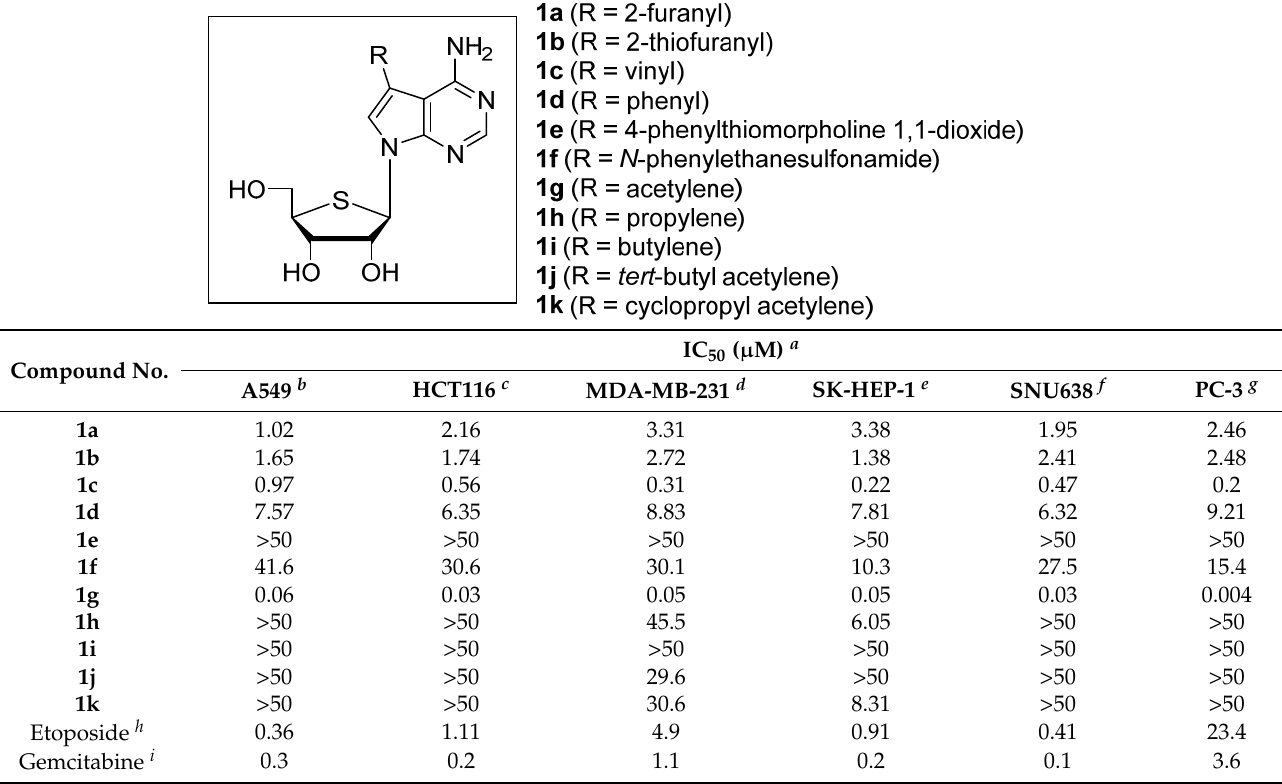
Table 1. Anticancer activity of the final 7-substituted 7-deaza-4’-thionucleosides 1a-k against several human cancer cell lines.